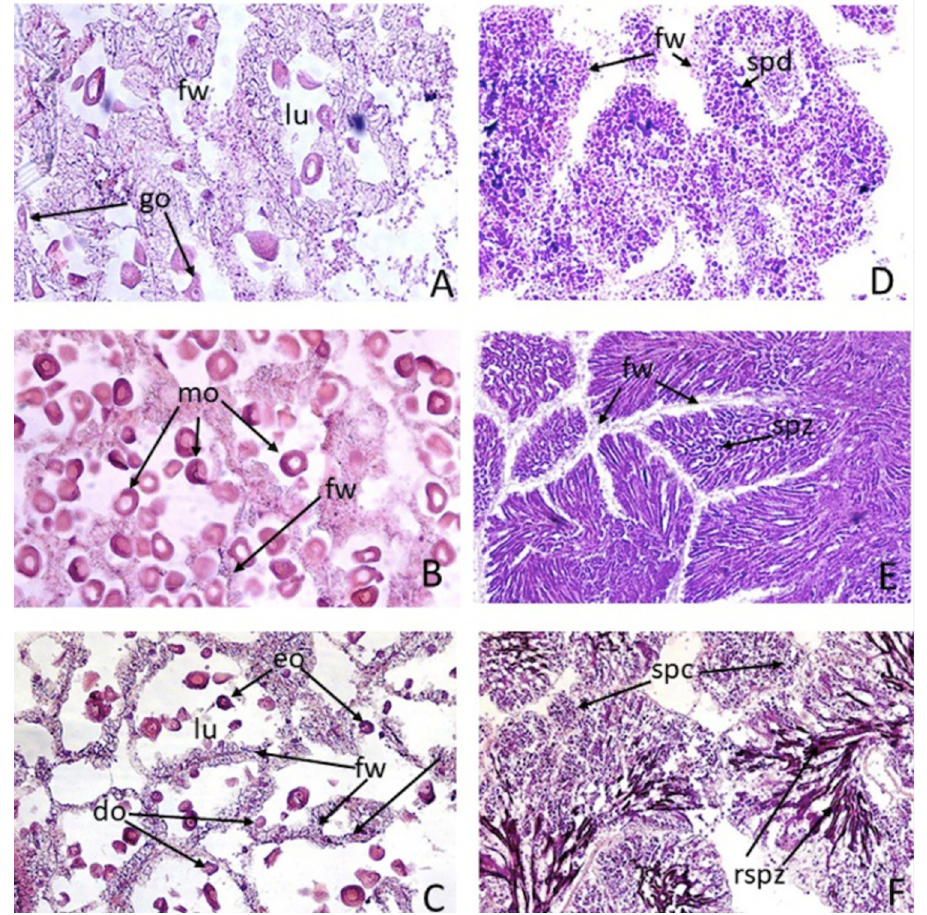
Fig 2. Microphotographs of gonadal states of A . antiqua . (A) "in development" female; (B) "ripe" female; (C) "spawned" female; (D) "in development" male; (E) "ripe" male; (F) "spawned" male. Microphotographs of cross sections of testicle and ovary stained with HE (1000X). Fw: follicular wall; spd: spermatids; Spz: spermatozoa; rspz: remains of spermatozoa; lu: lumen; eo: early oocytes; go: growing oocytes; mo: mature oocytes; do: deteriorating oocytes.